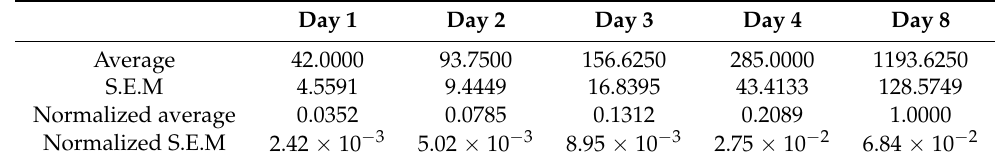
Figure 1. ( a ) Drawing of the transducer used for the culturing of PC-3 cells. PC-3 cells are represented as red circles within the culture medium. ( b ) PC-3 cells adhered to the gold electrodes 3 days after being deposited. ( c ) Cell viability describing a typical exponential PC-3 cell growth in the MEA device. Table 1. Average, S.E.M, normalized average and normalized S.E.M.